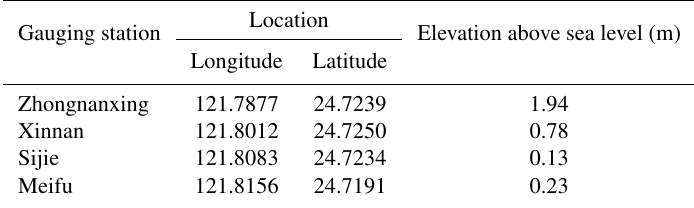
Table 1. Water-level gauging network in Xinnan area.